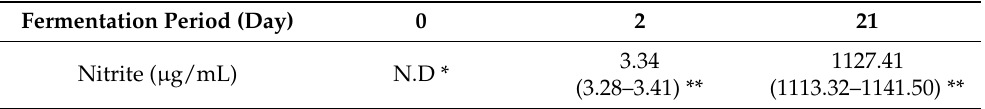
Table 1. Nitrite contents of fermented lettuce